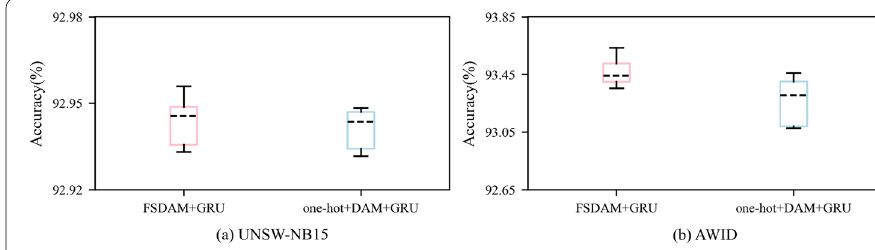
Fig. 8 Comparison results with one-hot method on two data